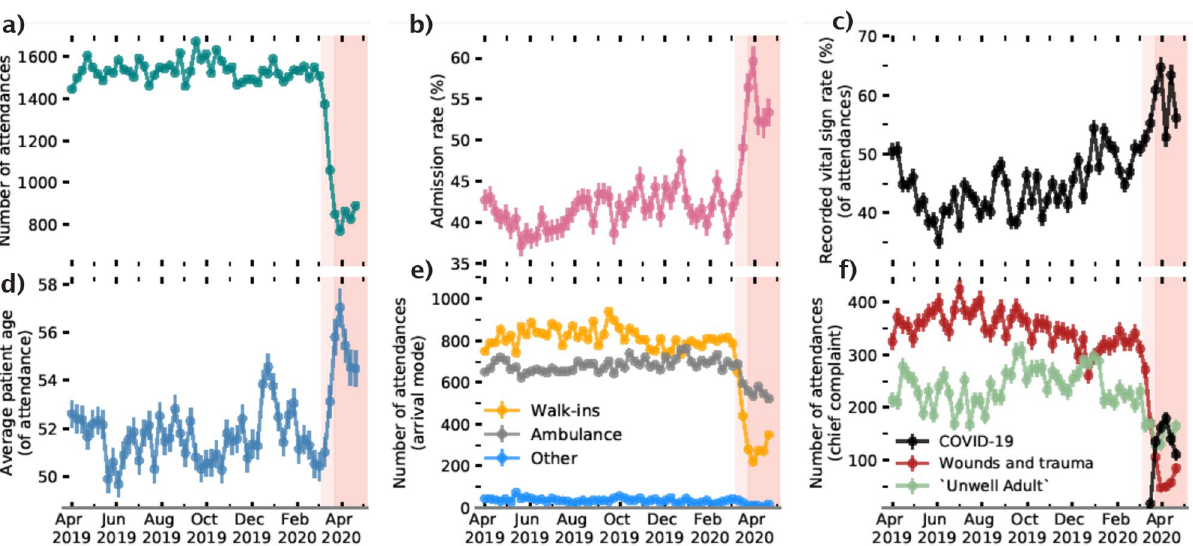
Figure 2. ED attendance statistics as a function of time. (Top row left-to-right) Number of weekly attendances, percentage of attendances that resulted in admission to hospital, and the percentage of attendances with vital sign measurements recorded. (Bottom row) Average age of the patient attending, mode of arrival to ED and chief complaints on attendance. COVID-19 recorded at the point of discharge. The red shading is consistent with the timeline in Fig.